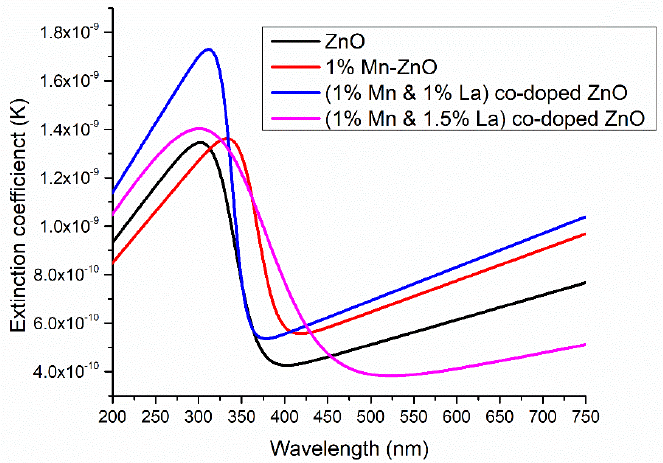
Figure 9. Extinction coefficient of undoped and doped ZnO thin films.